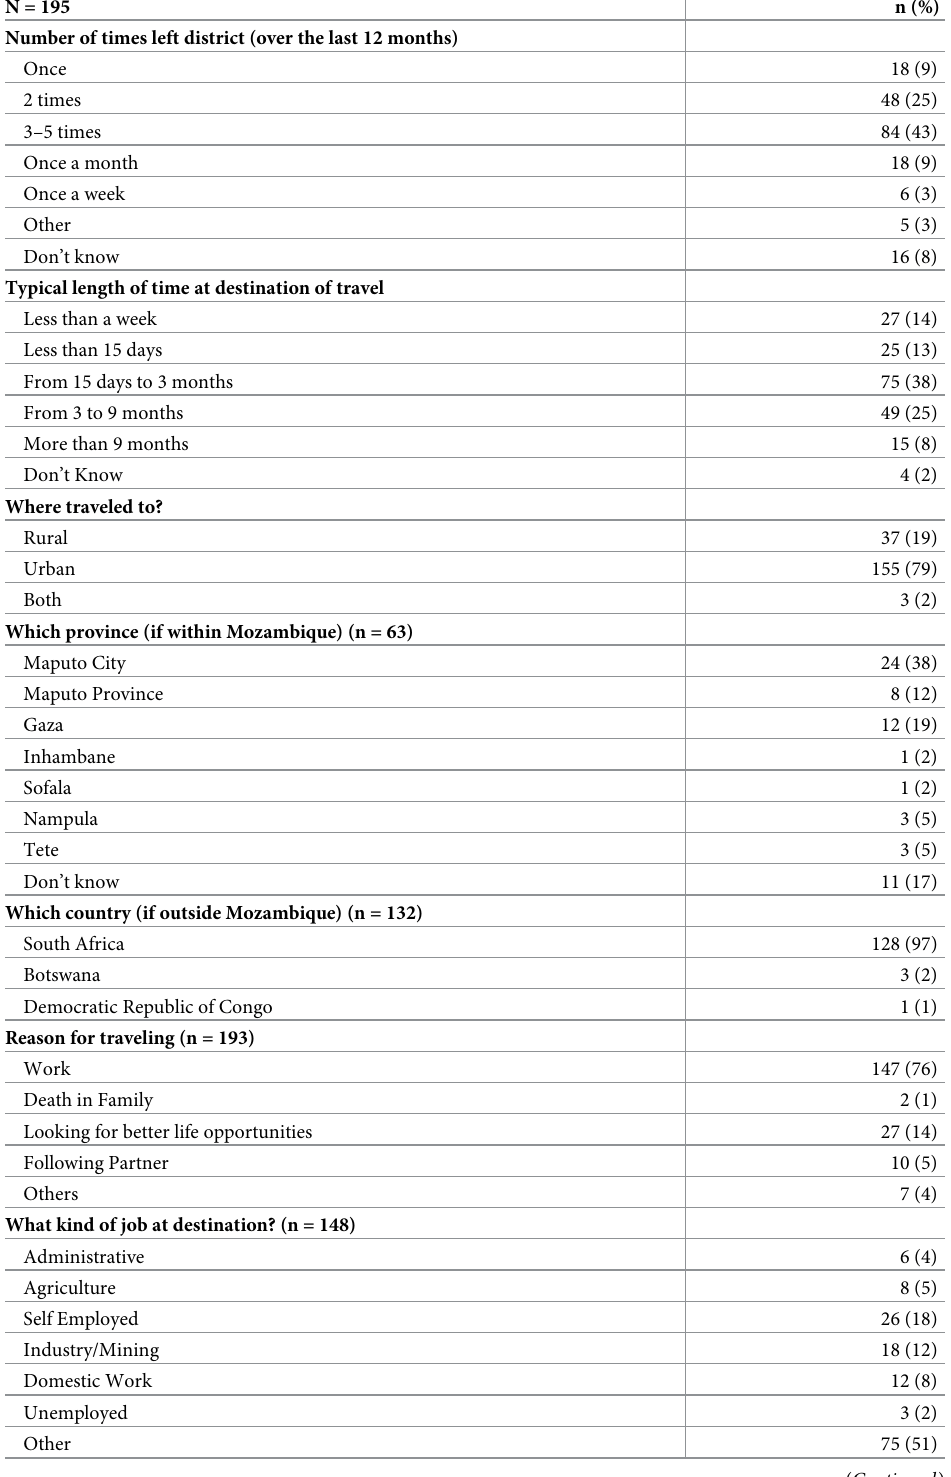
Table 2. Migration patterns and characteristics of mobile HIV-infected adults enrolled in HIV care and treatment at Manhic¸a District Hospital. N = 195 n (%) Number of times left district (over the last 12 months) Once 18 (9) 2 times 48 (25) 3–5 times 84 (43) Once a month 18 (9) Once a week 6 (3) Other 5 (3) Don’t know 16 (8) Typical length of time at destination of travel Less than a week 27